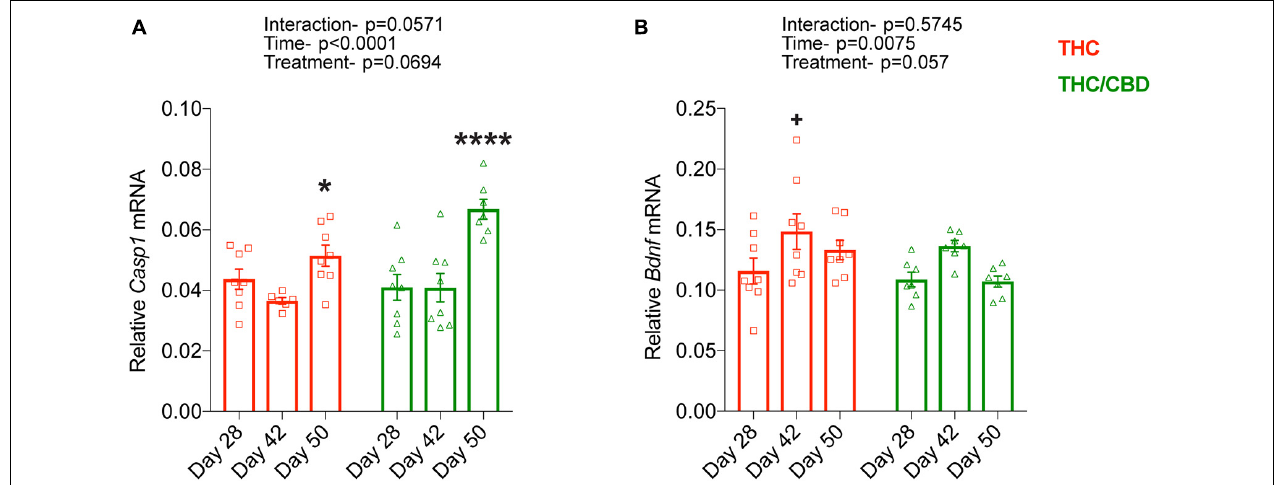
FIGURE 4 | Time-course of THC- and THC/CBD-induced gene expression. (A,B) Time dependent changes in Casp1 and Bdnf expression in THC- and THC/CBD groups in the hippocampus of old mice. A significant time-dependent but not treatment specific changes in the expression of Casp1 and Bdnf were observed in both THC- and THC/CBD-groups. (A) Casp1 expression moderately and substantially increased in THC-and THC/CBD-groups, respectively at day 50. (B) Whereas, Bdnf expression significantly increased at day 42 in THC-group but not in THC/CBD-group ( n = 6–8 mice per group). Data represented as meam ± SEM, * p < 0.05 (difference between days 42 and 50 of THC-group), **** p < 0.0001 (difference between day 28/day 42, and day 50 of THC/CBD-group), + p < 0.05 (difference between days 28 and 42 of THC-group); 2-way ANOVA with Sidak’s multiple comparison